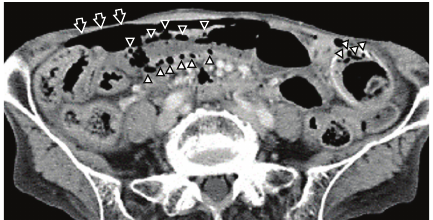
Figure 2: An abdominal computed tomography image demonstrat- ing a large quantity of free air in the abdominal cavity (arrows). Multiple small cysts are seen within the wall of the small bowel (arrowheads), consistent with pneumatosis cystoides intestinalis in this patient with systemic sclerosis.